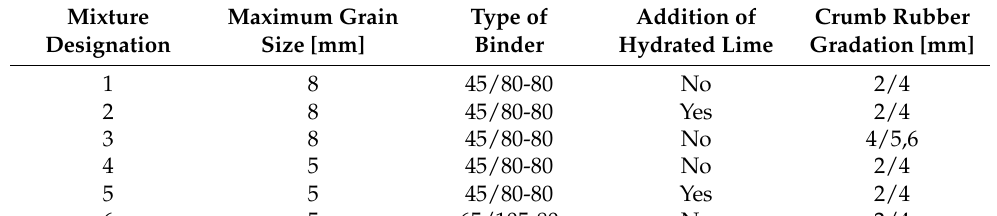
Table 1. Summary of different poroelastic mixtures selected for laboratory acoustic tests.